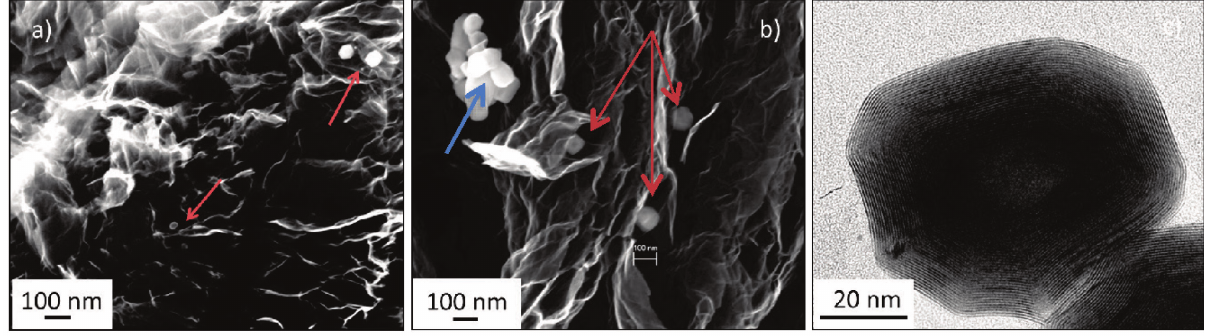
Figure 7. Microstructural Analysis of Graphene/IF-WS Electron Microscopy images of ( a ) Graphene/IF-WS ( b ) Graphene/IF-WS hybrid made directly from Graphene and WO 2 electron micrograph showing the characteristic hollow core and interlayer spacing for IF-WS 2